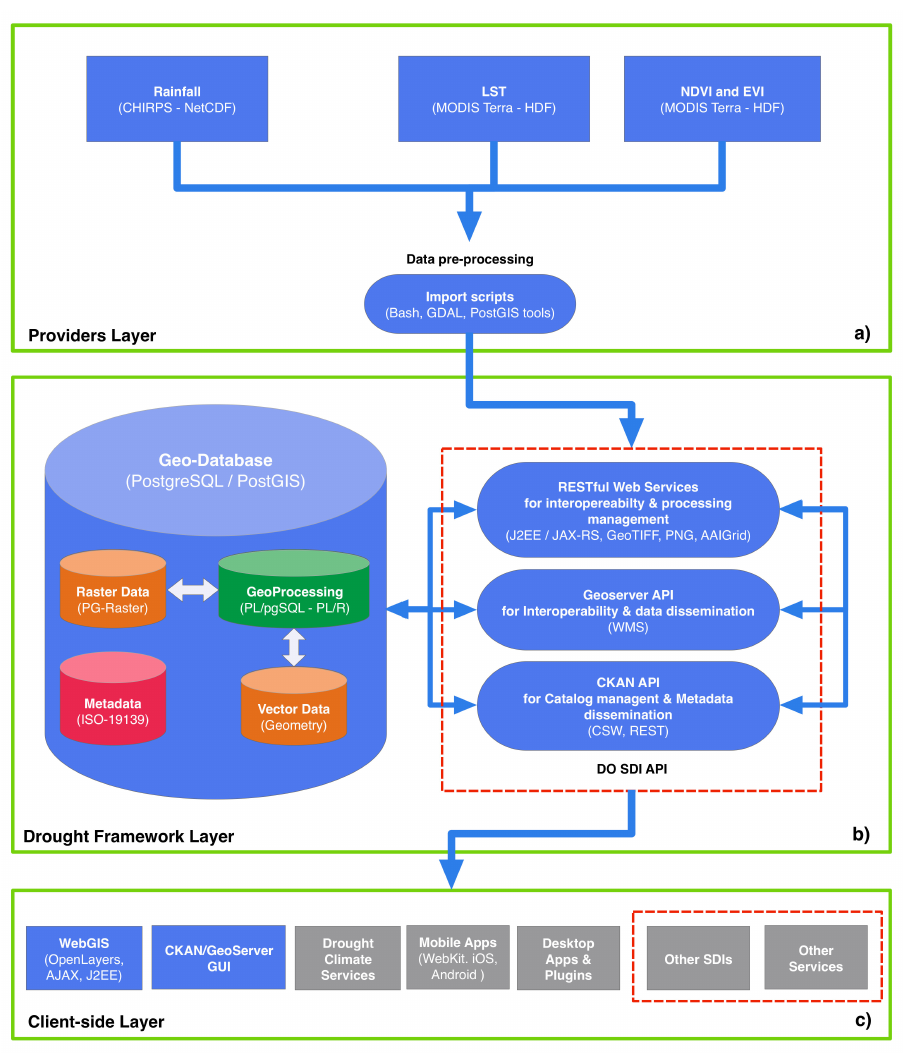
Figure 6. Drought observatory architecture and web services for data import, storing and geoprocessing: ( a ) providers layer; ( b ) framework layer; ( c ) client-side